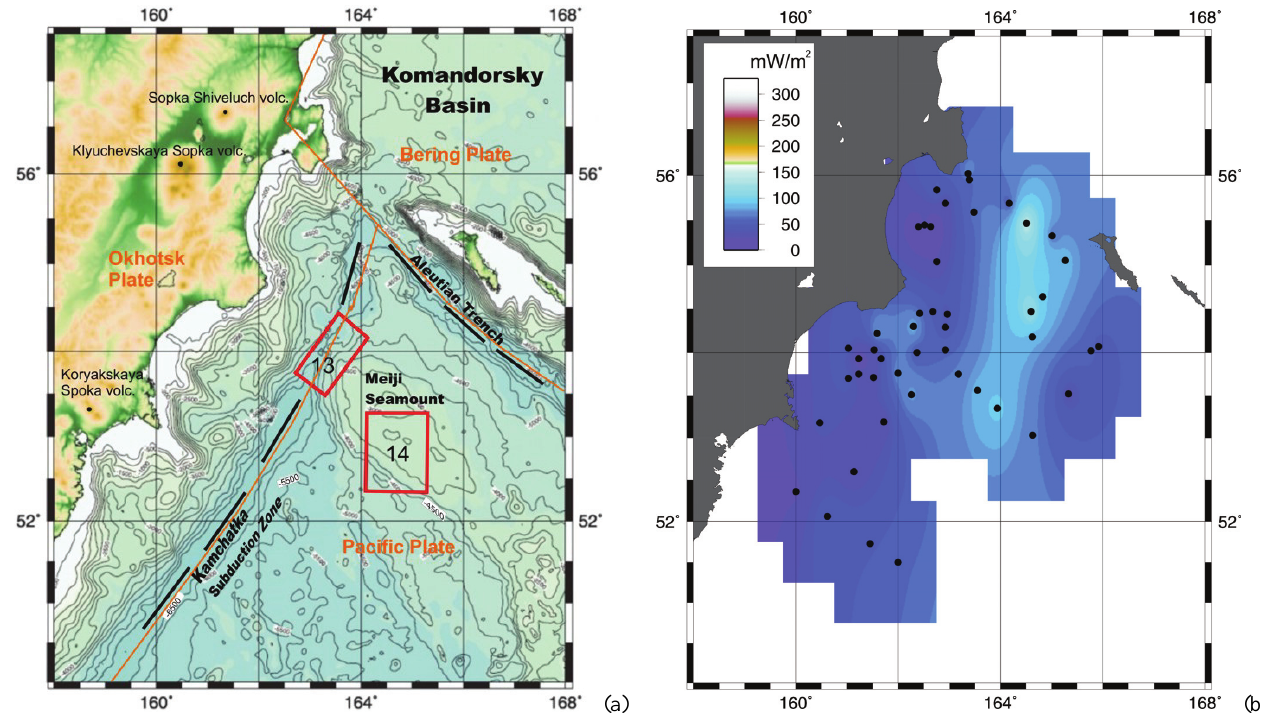
Fig. 1. (a) Bathymetric map of the southern portion of the research area investigated by a German-Russian team during cruise SO201-2 with R/V Sonne . Research permits for heat flow measurements were granted only for areas 13 and 14. Map was processed with GMT, Mercator projection (WGS 84); bathymetry by GEBCO. (b) Isoline plot of previously measured heat flow values measured by Russian workers in the late 70ies to early 80ies of last century (data taken from Smirnov et al.,